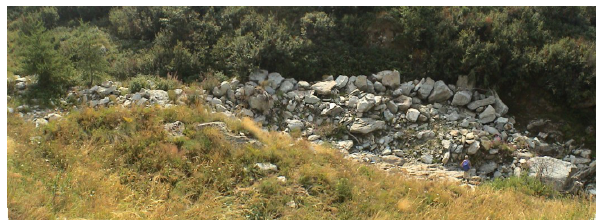
Figure 9. Residual deposit of a debris flow (October 2000), which shows typical inverse gradation, along a left tributary of the Soana stream (photo 8 August